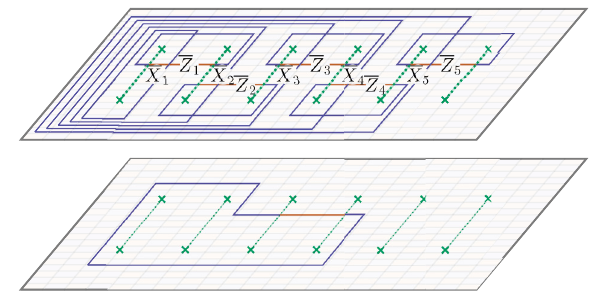
FIG. 19. Encoding n qubits in 2 n + 2 twists. Top: the gener- ating set of logical operators is traceable. Bottom: example of a product of Pauli generators that is also traceable. A general Pauli operator can be associated with the twists it encloses. In Fig. 28 below we show that all Pauli operators are